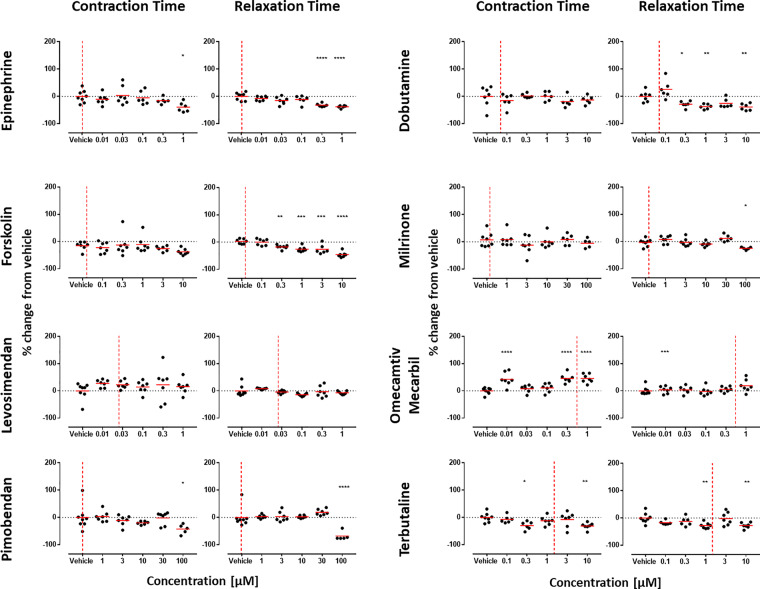
Refined culture conditions increase predictivity of positive inotropes (PIs) in 2D monolayers of hiPSC-CMs. Contraction analysis was carried out on the 8 PIs from the drug test set using the CO:R-PAT platform-cell combination. Only CT and RT are shown because data in Figure 3 showed these to be the most informative parameters for PIs. Whereas testing in serum-/protein-free medium failed to identify any PIs correctly (A, web tool), the slowed beat rate and improved signal-to-noise ratio afforded by culture in RPMI-B27 allowed correct identification of 6/8 PIs by significant decreases in CT and/or RT. Red dotted line is free therapeutic plasma concentration. Dunnett’s stats versus vehicle control: *p < .05; **p < .01; ***p < .001; ****p < .0001.